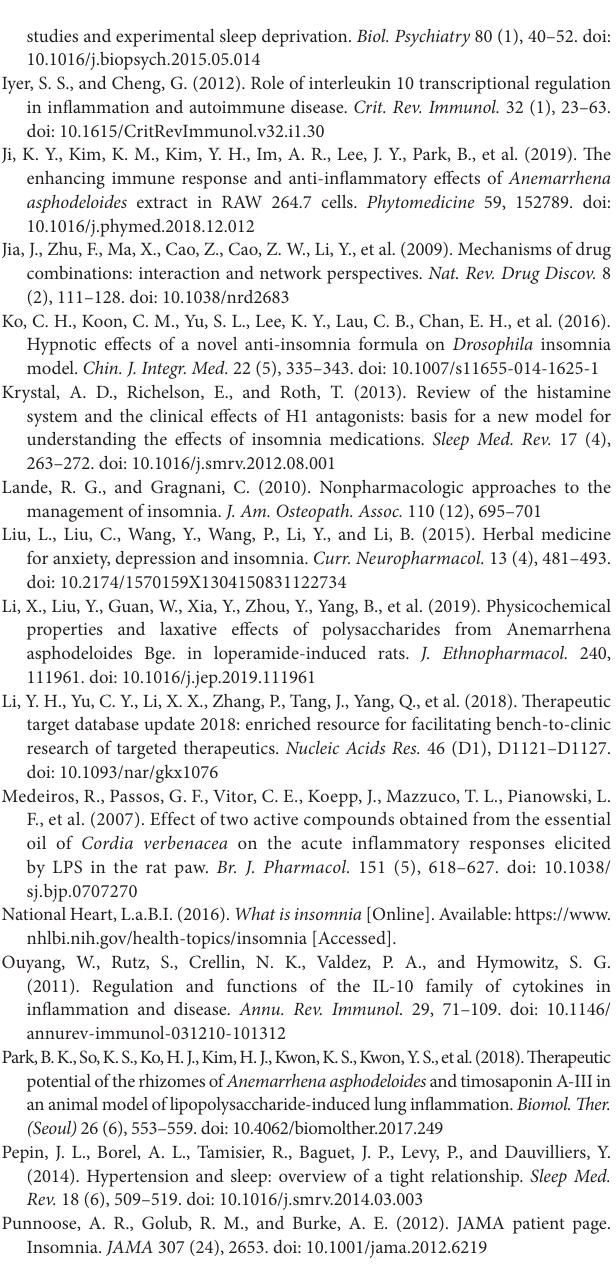
TABLE S1 | 497 targets of 5 herbs in SZRP. TABLE S2 | Top 50 pathways of functional enrichment analysis. TABLE S3 | Original information of targets in Figure